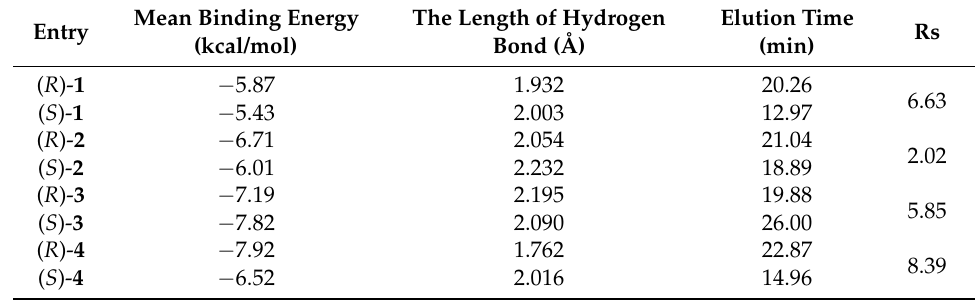
Table 2. The calculated average binding energies for compounds 1 – 4 on the ChiralPak AD-H column. Mean Binding Energy The Length of Hydrogen Elution Time Entry (kcal/mol) Bond (Å)